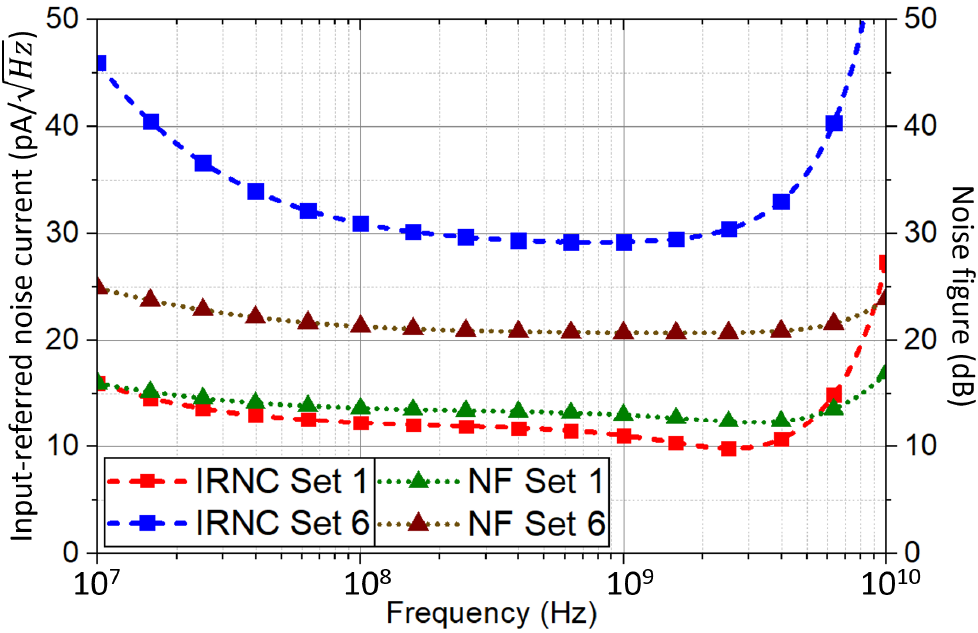
Figure 9. Simulated IRNC and NF of the TIA at maximum and minimum gain settings. The IRNC and NF at 4 GHz for the maximum gain setting are 10.7 pA/ 12.4 dB, respectively. The dynamic range lower limit is determined by IRNC at maximum gain and 4 GHz, as well as using a signal to noise ratio (SNR) of 49 for TIA specification [8]. This gives a minimum I in ( i pd ) of 33.2 µ A. The dynamic range upper limit is determined by the IP 1dB at minimum gain during high I in . Using P in = I 2 1.46 mA. Thus, using the gain range as a parameter allows for both the IRNC and the IP 1dB of the TIA design.